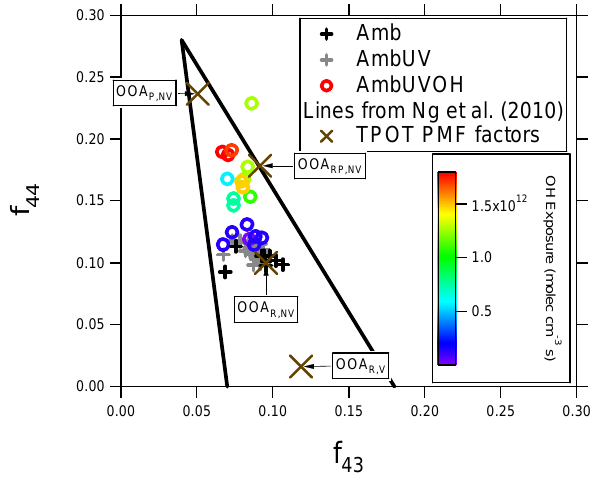
Fig. 4. Aerosol composition described in terms of the fraction of or- ganic mass at m / z 44 and 43 ( f 44 and f 43 ). Data points are colored by OH exposure, and lines denote the limits of PMF OOA factors resolved from ambient data (Ng et al., 2010). Values for TPOT PMF factors are also shown.